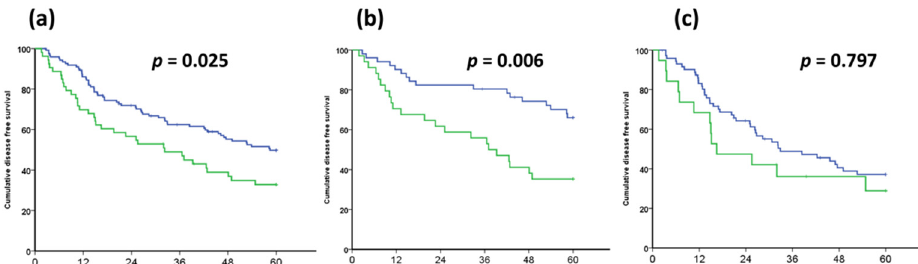
Figure 1. Kaplan–Meier survival curves of the VETC + and VETC − groups in patients with HCC who underwent partial hepatectomy. Different long-term outcomes of patients with HCC, stratified according to the presence or absence of the VETC pattern. The Kaplan–Meier analysis showed the disease-free survival in ( a ) the entire cohort, ( b ) the HBV group, and ( c ) the HCV group, from left to right. VETC, Vessels that Encapsulate Tumor Clusters; VETC + , positive VETC pattern; VETC − , negative VETC pattern; HCC, hepatocellular carcinoma; HBV, hepatitis B virus; HCV, hepatitis C virus; VETC + group, green line; VETC − group, blue line.